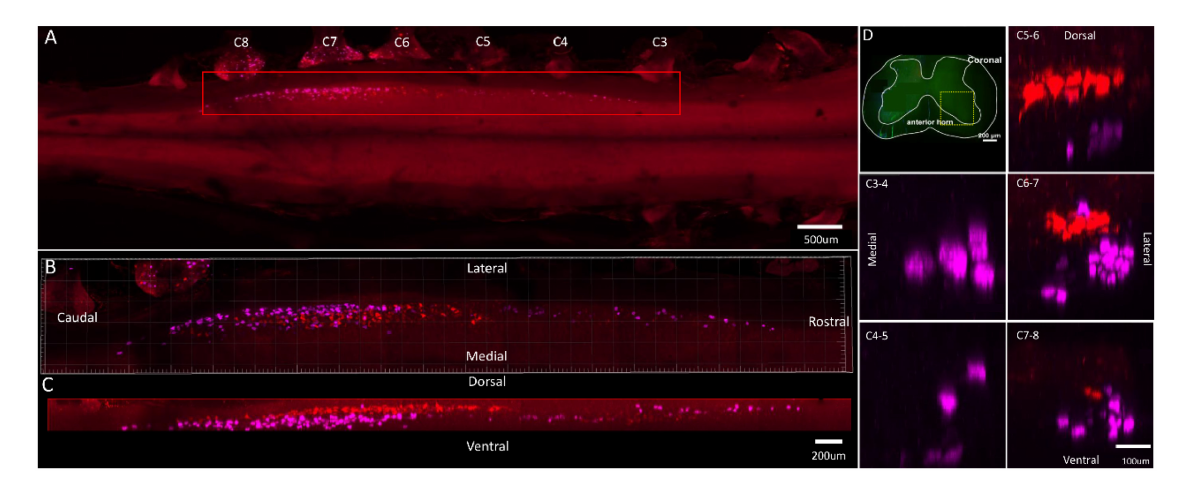
FIGURE3 Distribution characteristics of motor neurons targeting triceps (labeled by FG, red), and extensor indicis (labeled by CTb-647, purple). (A) Spatial images of multi-tracks in a holistic view. (B,C) The relative spatial positions of the motor neuron columns targeting different muscles in sagittal and corona viewing angles. (D) The schematic diagram of the distribution of different motor neuron columns in the anterior horn of the spinal cord. The yellow box that outlines the region of interest is amplified in the subpanels in panel (D) . The cross-sectional images are maximum projections of different parts of the spinal cord. The motor neurons innervating triceps have little overlapping with extensor indicis.